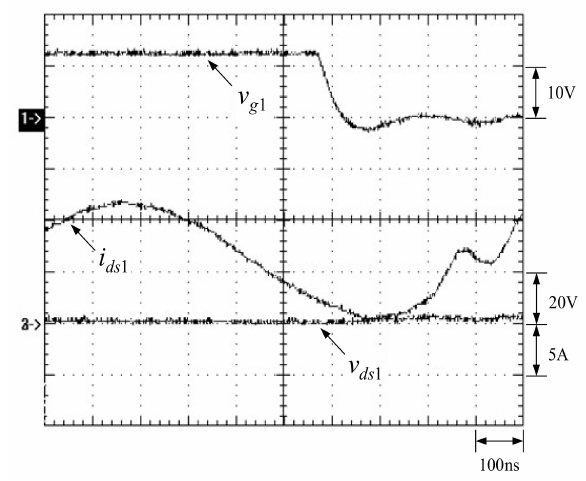
Figure 14. Zoom-in of Figure 12 for ZCS turn-on of S 1 .